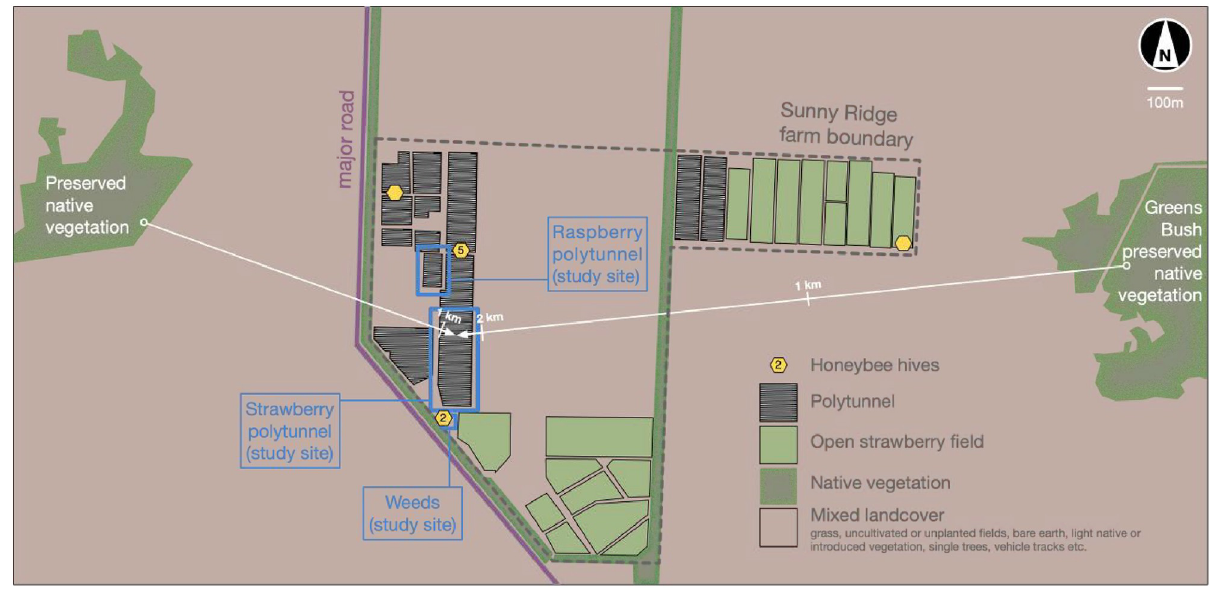
Fig 1. Satellite image of Sunny Ridge farm 38˚25’25.2"S 144˚53’33.8"E (perimeter indicated by dotted grey line). Managed honeybee hives (yellow hexagons) with the number of hives at locations close to study sites indicated. Raspberry/strawberry polytunnels and the weed location used in the study are marked. Nearby areas of native bushland are indicated along with their ranges from the strawberry polytunnel for reference.